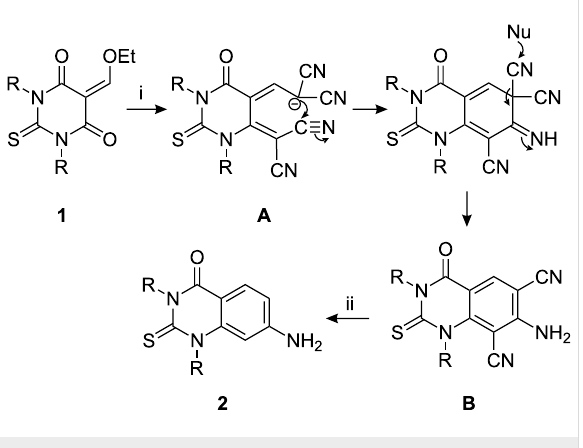
Scheme 2: Synthesis of 2 , reagents and conditions: (i) CH 2 (CN) 2 , NH